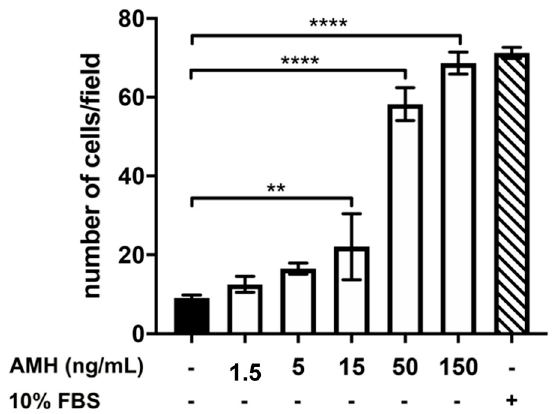
Figure 2. Effect of different concentrations of anti-Müllerian hormone (AMH) on GN11 cell migration. Data are expressed as mean ± SD, n = 8. One experiment representative of three separate experiments is shown. ** p < 0.01; **** p < 0.0001 (One-way ANOVA followed by the Dunnett post-hoc test).